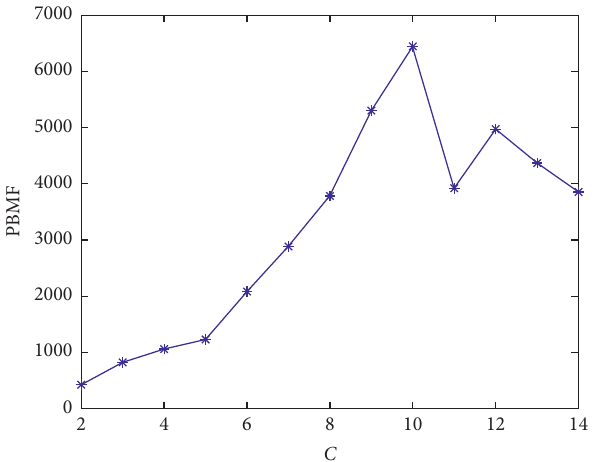
Figure 8: The cluster contour map of the proposed method.